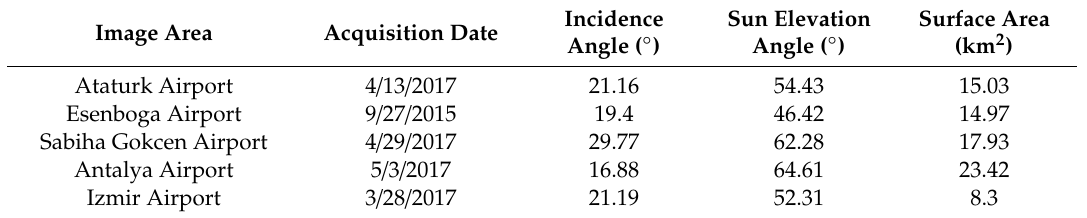
Table 1. Properties of Pleiades satellite images used for model construction and independent testing.